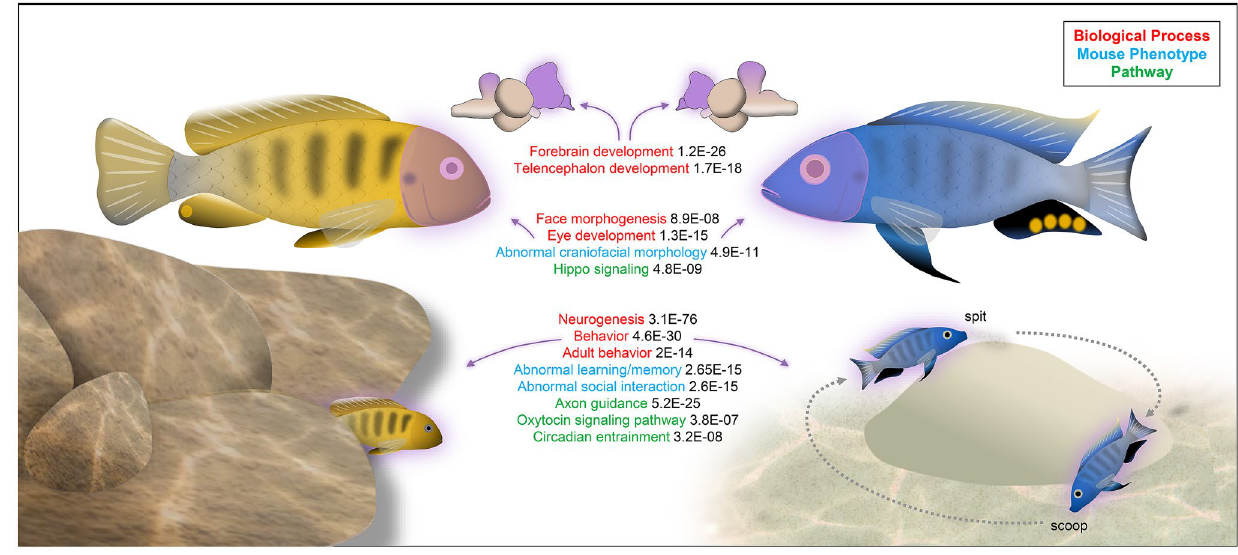
Figure 4. Genome-enabled discovery of evolutionary change in morphology and behavior. Summary cartoon synthesizing significant enrichment categories that differentiate the genomes of rock- vs. sand-dwelling